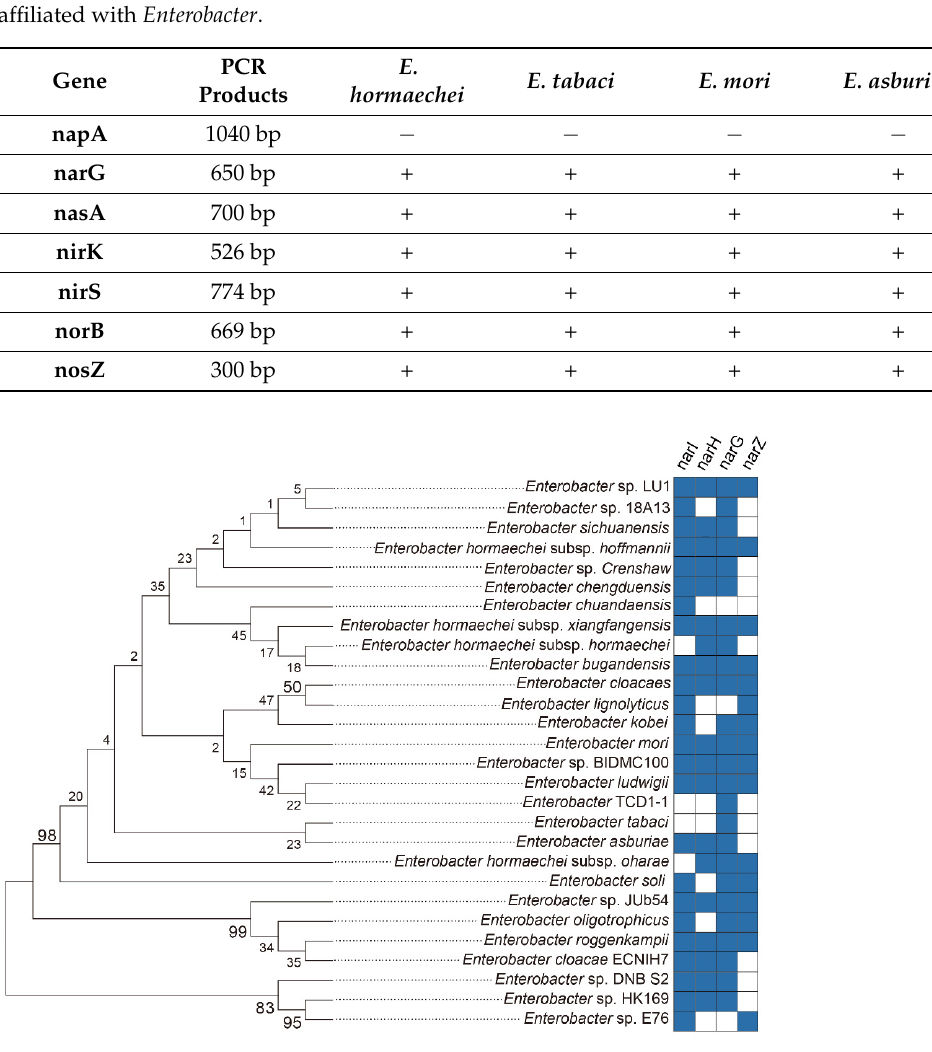
Figure 4. Nitrate-reducing genes harbored in the Enterobacter strains according to the NCBI database. Neighbor-joining (bootstrap: 1000 replicates) phylogenetic tree based on 16S rRNA gene sequences indicating the phylogenetic position of the Enterobacter strains. Bar represents 1 substitution per 100 nucleotide positions. Bootstrap values above 50% are given at the node.